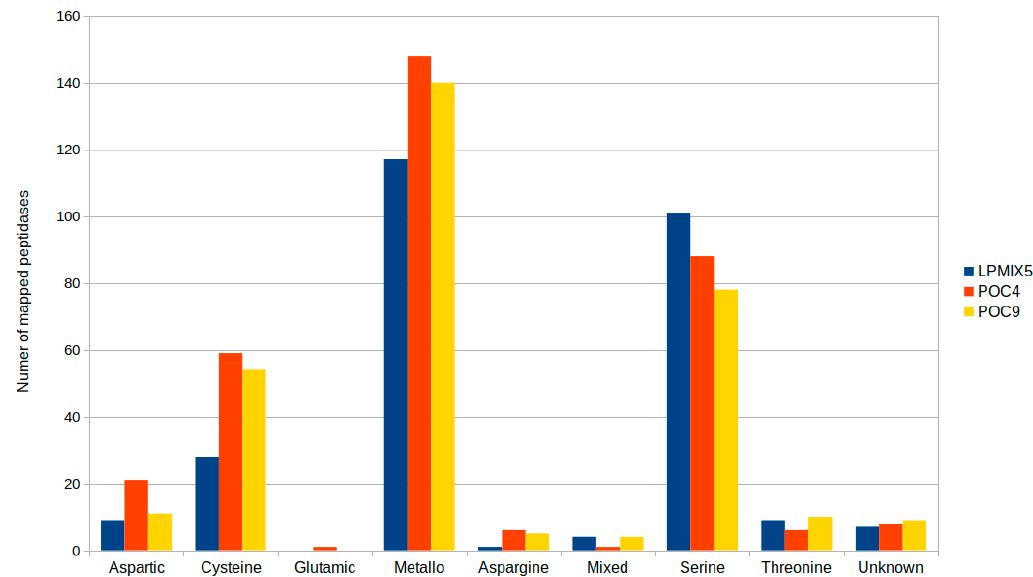
Figure 3. Mapping of the predicted proteins from the three investigated strains to the MEROPS peptidase database clan groups. Aspartic: clans of aspartic peptidases, Cysteine: clans of cysteine peptidases, Glutamic: clans of glutamic peptidases, Metallo: clans of metallo peptidases, Asparagine: clans of asparagine peptide lyases, Mixed: clans of mixed (C, S, T) catalytic type, Serine: clans of serine peptidases, Threonine: clans of threonine peptidases, Unknown: clans of peptidases of unknown catalytic type.